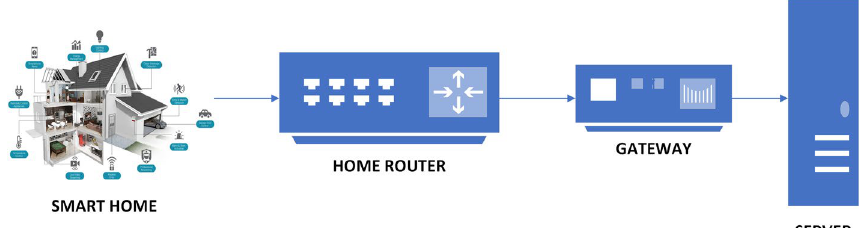
Fig. 2 Smart home with sensor nodes and routers